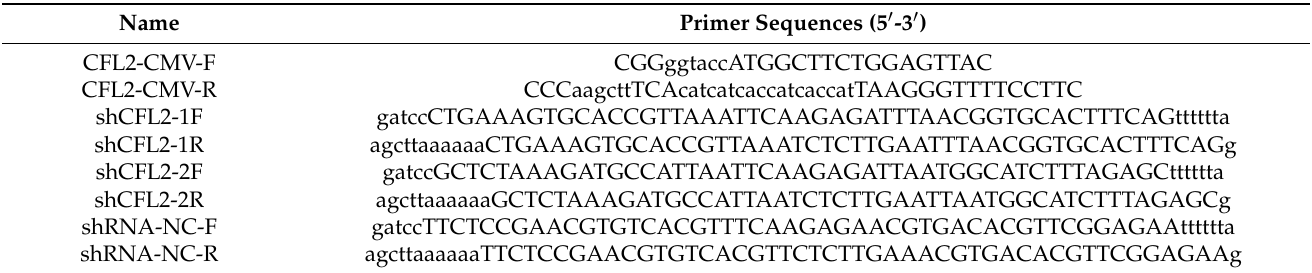
Table 1. Primer information (containing protective bases and restriction sites) for adenovirus vector construction.